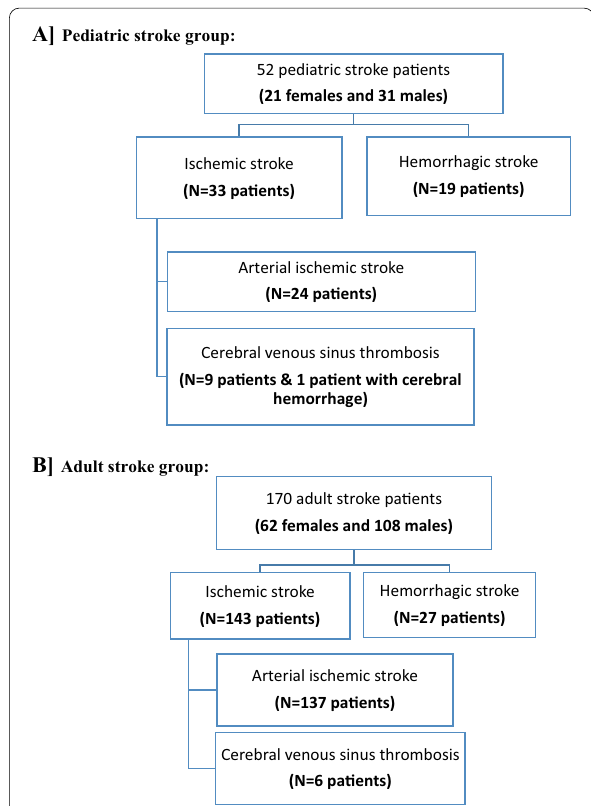
Fig. 1 Flowchart of ( A ) pediatric stroke group and ( B ) adult stroke group